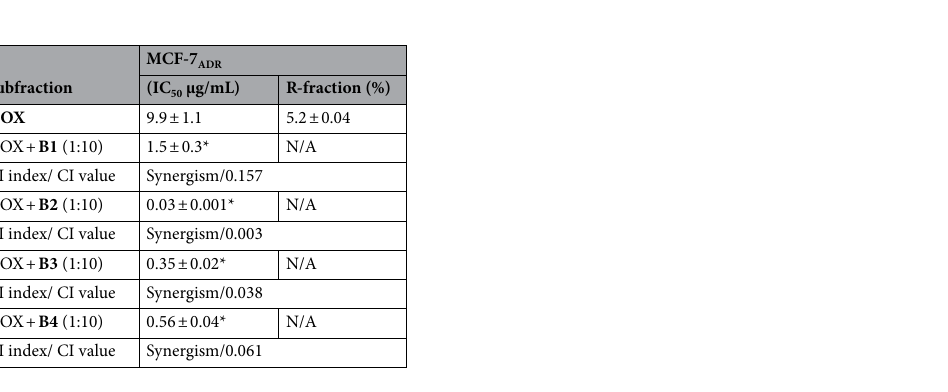
Table 5. Chemomodulatory effect of subfractions (B1–B4) of Fr-3 on the cytotoxicity of DOX against MCF- 7 ADR cell line. # N/A means not applicable. Data are presented as mean ± SD; n = 3. *Significantly different from DOX